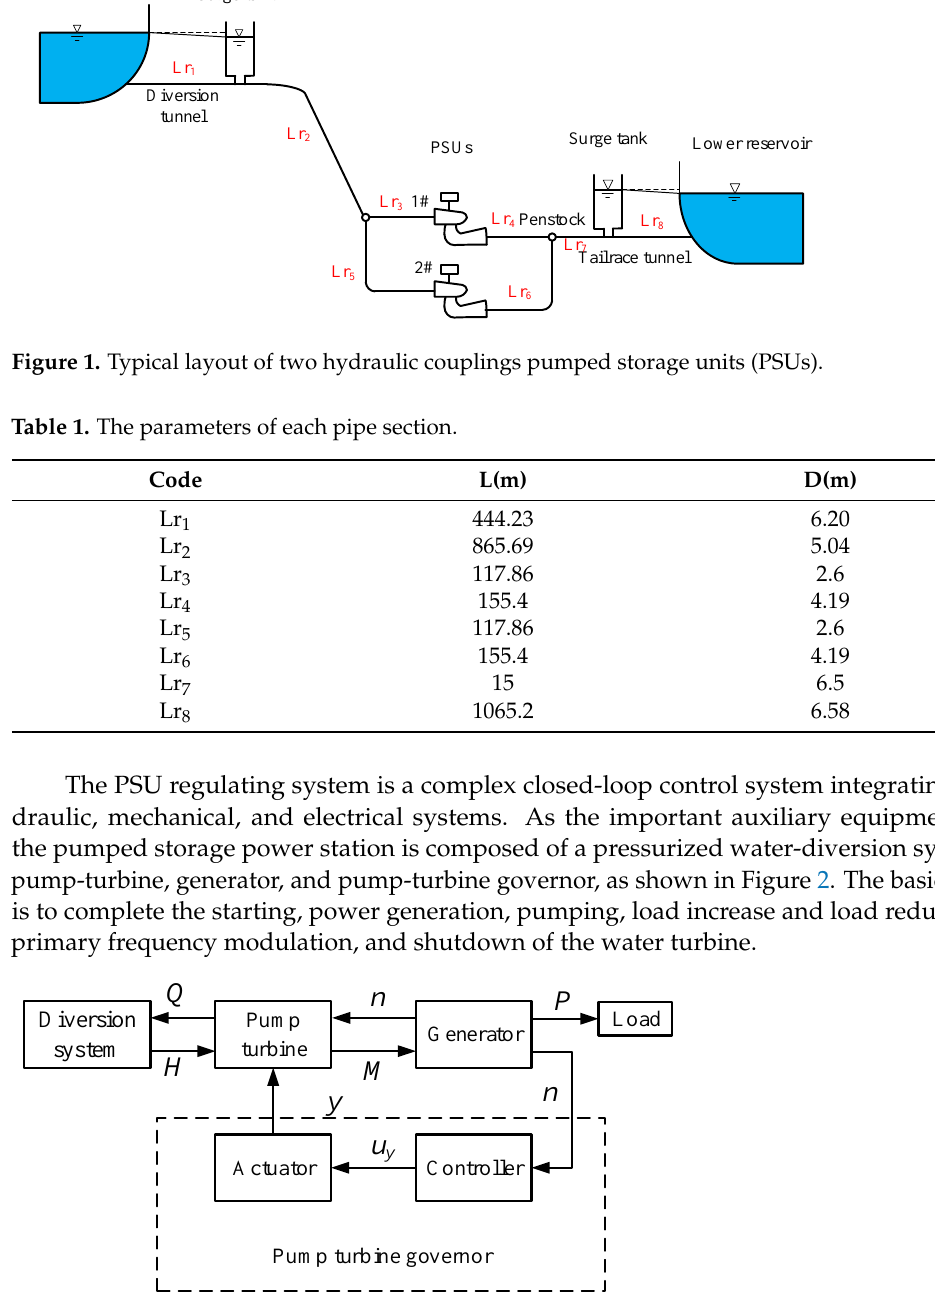
represents the torque of the pump-turbine; P represents the output power of the generator; y represents the opening of the guide vane; u y represents the output of the controller and adjust guide vane opening